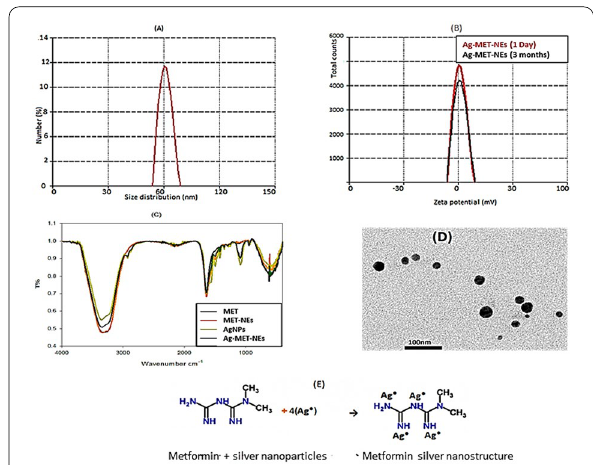
Fig. 1 A Size distribution of Ag-MET-Ns at 66 nm, B Zeta potential of Ag-MET-Ns, C FT-IR of Metformin, MET-Nano, AgNPs and Ag-MET-Ns, D TEM image of Ag-MET-Ns and E image of Ag-MET-Ns stabilized form